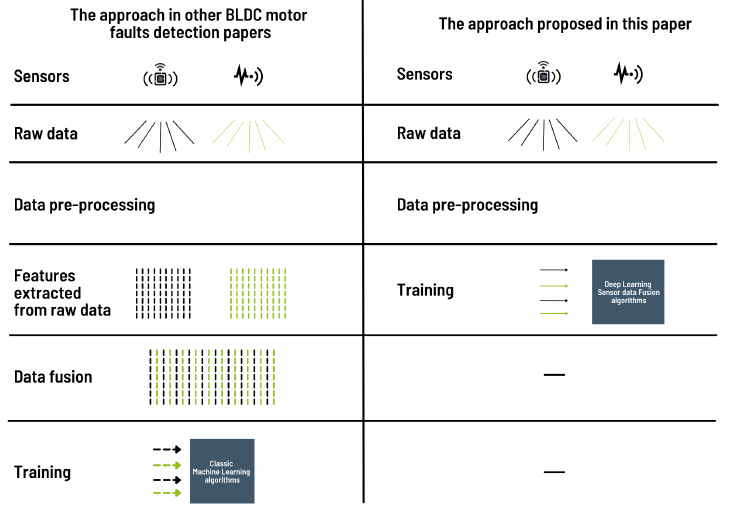
Figure 1. Comparison of the approach used so far with the proposed approach for the BLDC motor fault detection